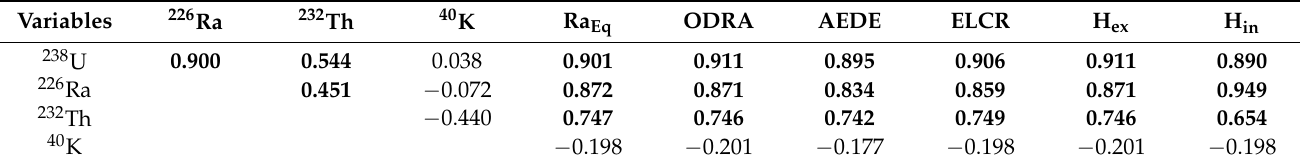
Table 6. Spearman rank-order correlation coefficients between radiological variables in soil and sediments